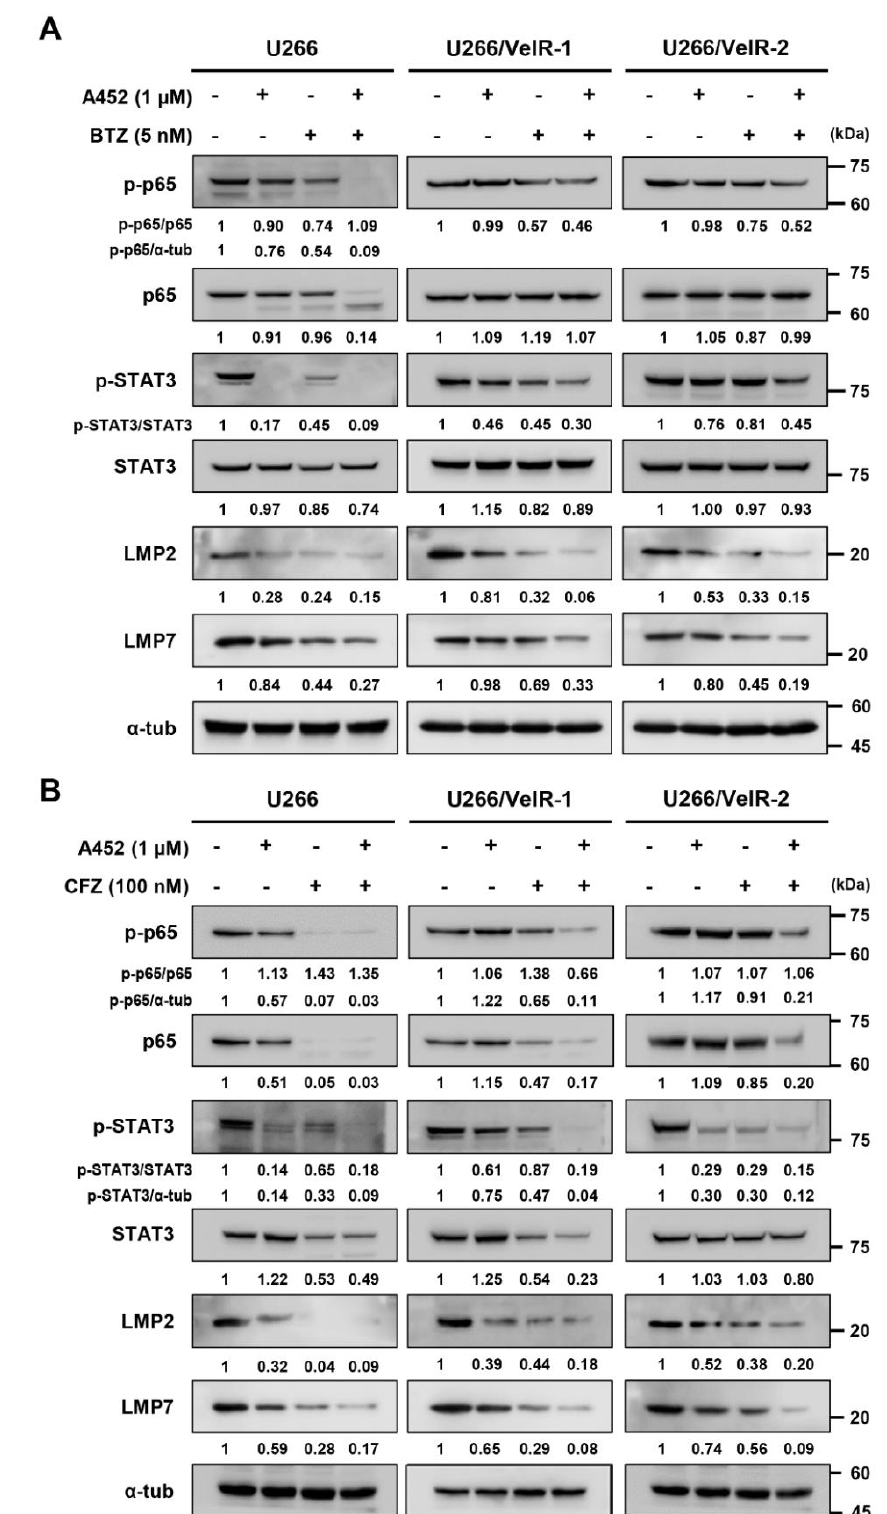
Figure 7. Cotreatment of A452 and PI synergistically decreases the level of low-molecular-mass polypeptide 2 (LMP2) and LMP7 via modulating signal transducer and activator of transcription 3 (STAT3) and nuclear factor kappa B (NF-κB) pathways in both BTZ-sensitive and BTZ-resistant U266 MM cells. ( A , B ) Both BTZ-sensitive U266 and BTZ-resistant U266 (U266/VelR-1 and U266/VelR-2) MM cells were treated with 0.1% DMSO (control), A452, BTZ ( A ), and CFZ ( B ) or in combination with A452 and PI as indicated for 24 h. Whole-cell lysates were subjected to immunoblotting with indicated